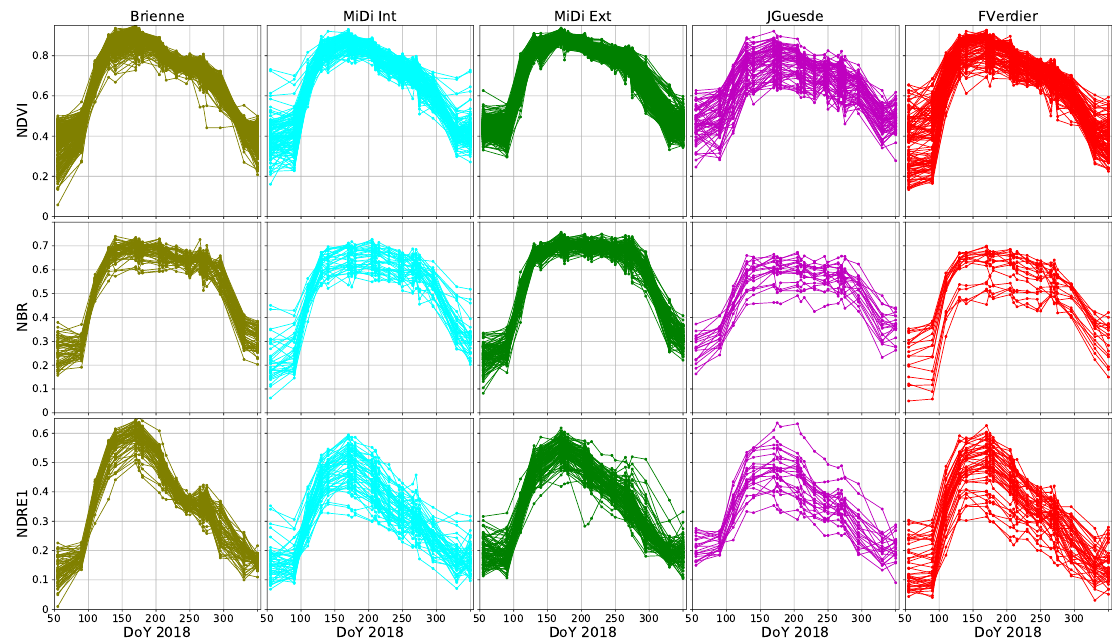
Figure 7. The 2018 London plane raw phenological curves for pixels classified as vegetation with NDVI ( top ), NBR ( center ) and NDRE1 ( bottom ) for the five studied sites from left to right: Brienne, Midi Int, Midi Ext, JGuesde and FVerdier. Table 2. Curve fitting classification performances for NDVI, NBR and NDRE1. # indicate the number of pixels and “std” the standard deviation of the VI values of the vegetation pixels during the maturity period. NDVI NBR